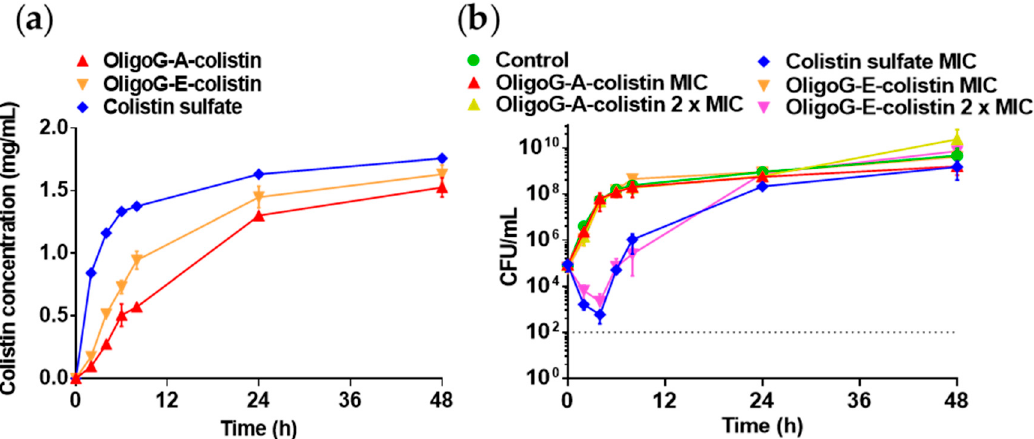
Figure 4. Pharmacokinetic–pharmacodynamic (PK–PD) model to compare diffusion of free- and OligoG-conjugated colistin. ( a ) Change in colistin concentration in the outer compartment over 48 h (measured by BCA assay). Data are expressed as mean ± SD ( n = 3). ( b ) Viability count of A. baumannii 7789 in a “time-to-kill” (TTK) model. Data represent mean colony forming units (CFU) ± SD ( n = 3). Dotted line, lower limit of detection (10 2 CFU/mL). Abbreviations: A, amide; E, ester.